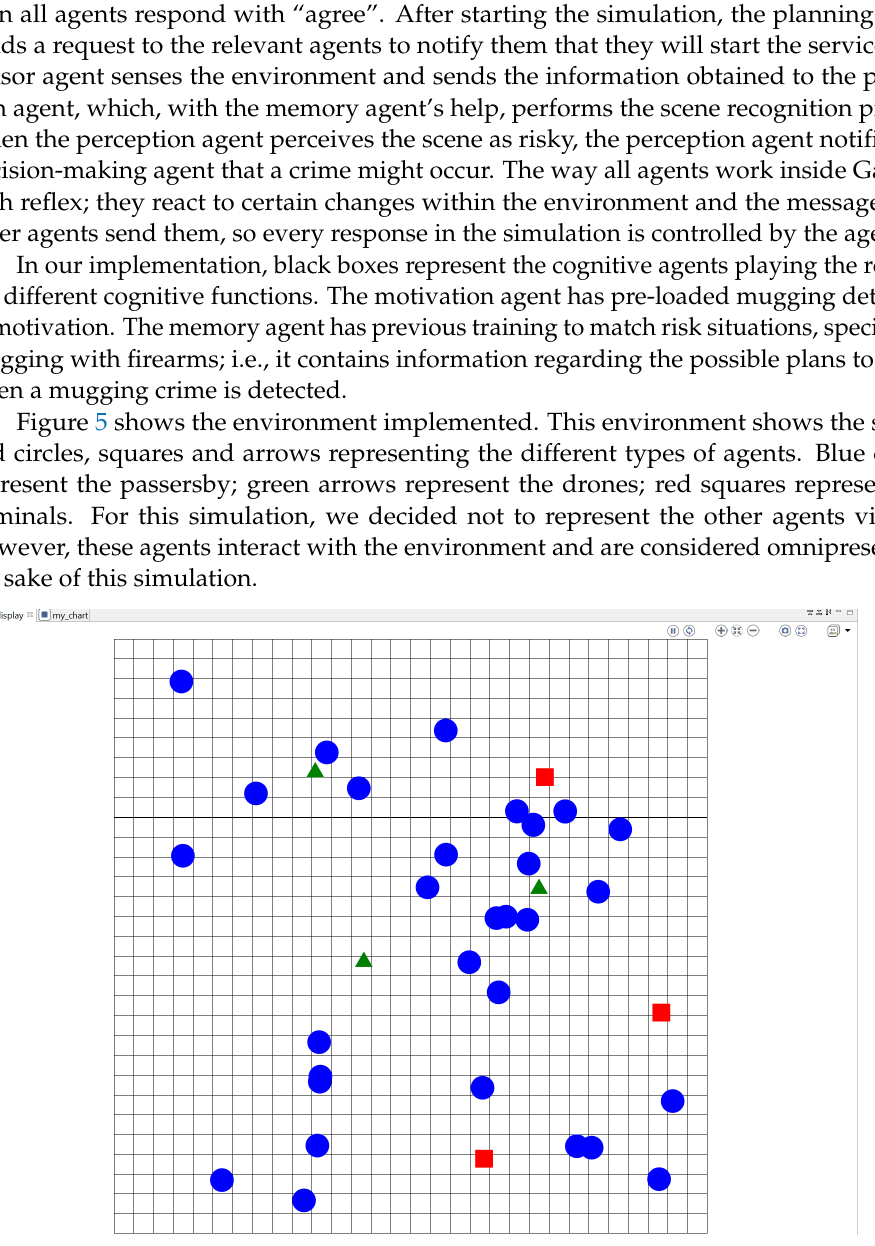
Figure 5. Environment in